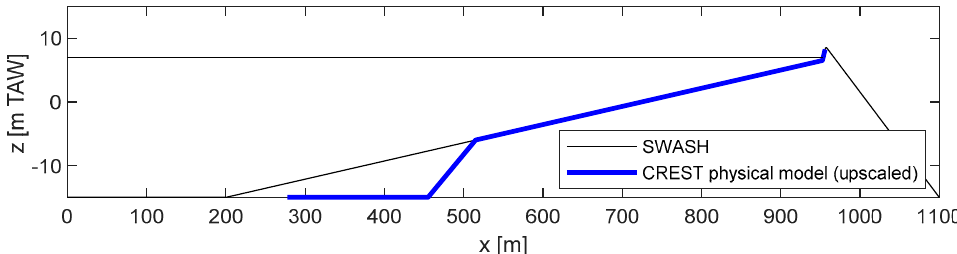
Figure 2. Comparison of the cross section of foreshore and dike profile between the SWASH model and the CREST physical model.